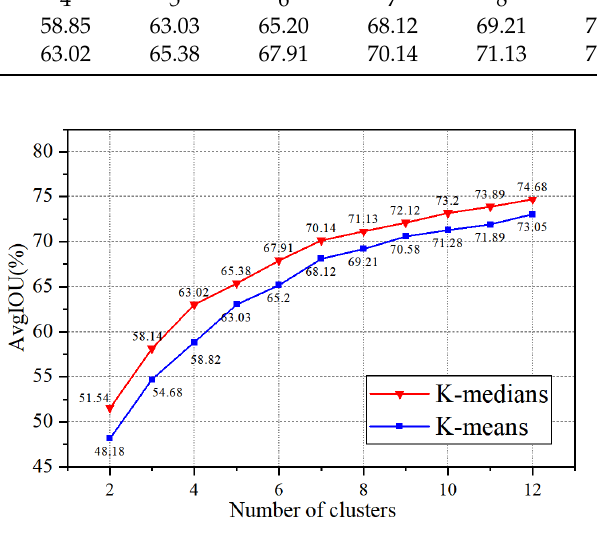
Figure 6. AvgIOU of the K-means method and K-medians method on the studs dataset.